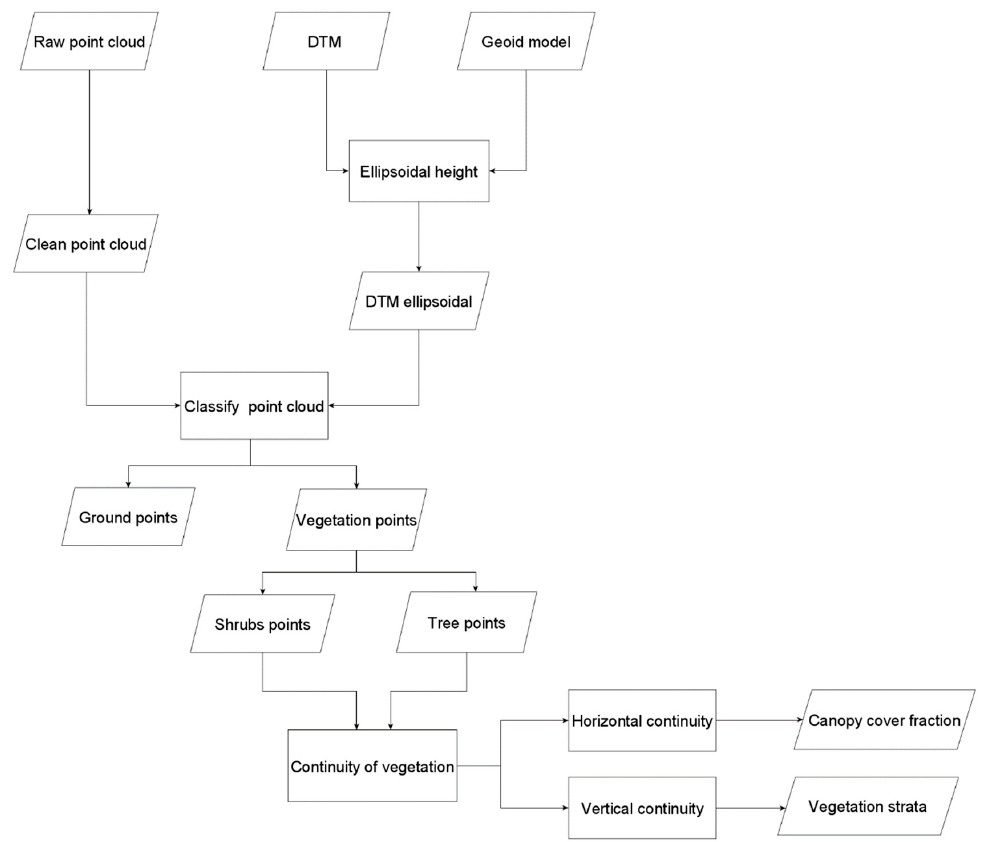
Figure 4. Workflow of the methodology to determine continuity of vegetation.